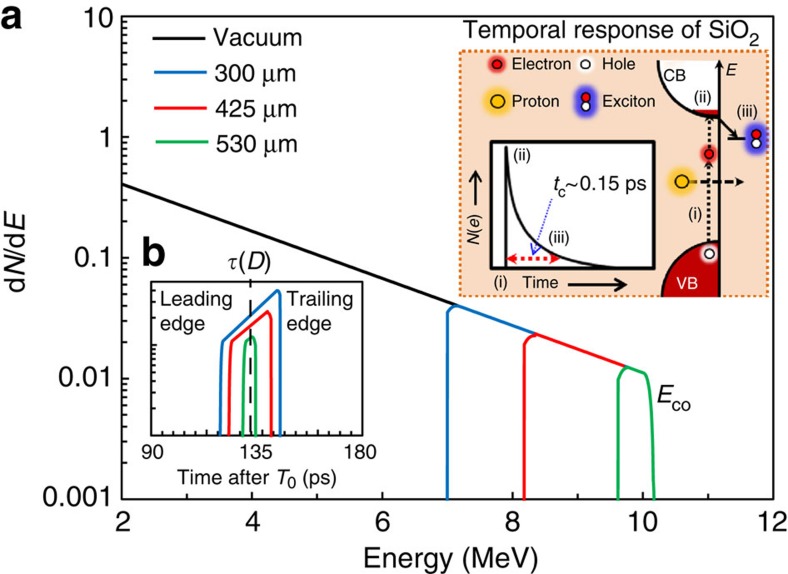
Ultrafast proton pulse metrology in SiO2.The dashed inset shows a schematic of the intraband dynamics and temporal response of an excited electron in a-SiO2. VB and CB are the valance and conduction bands, respectively, and E is the energy. Exciton formation provides the ultrafast de-excitation pathway for electrons in the CB8. The time constant for exciton formation is ∼0.15 ps (refs 8, 20). (a) Schematic of a TNSA proton spectrum (black trace) represented by a truncated exponential, with a proton temperature T=2 MeV and a high-energy spectral cutoff Eco=10 MeV. The coloured traces show the bandwidth of the original spectrum that remains after proton stopping at different depths D, in bulk SiO2 (density 2.66 g cm−3) from stopping and range of ions in matter (SRIM) calculations24 (see Methods for more details). This returns a continuously decreasing bandwidth with respect to D (up to the stopping depth for Eco, here ∼570 μm). The proton pulse duration τ(D) (b) is then simply the difference in time of flight for vacuum propagation (chosen here to be 5 mm) plus D for both the leading and trailing (high and low kinetic energy) edges of the remaining proton bandwidth. This illustrative schematic shows only the cumulative bandwidth narrowing of the originally broadband spectrum to reveal how short pulses can in principle be retrieved. It does not account for other aspects of the TNSA mechanism, such as energy-dependent cone narrowing121314 critical for determination of the detailed proton pulse profile for a particular D.